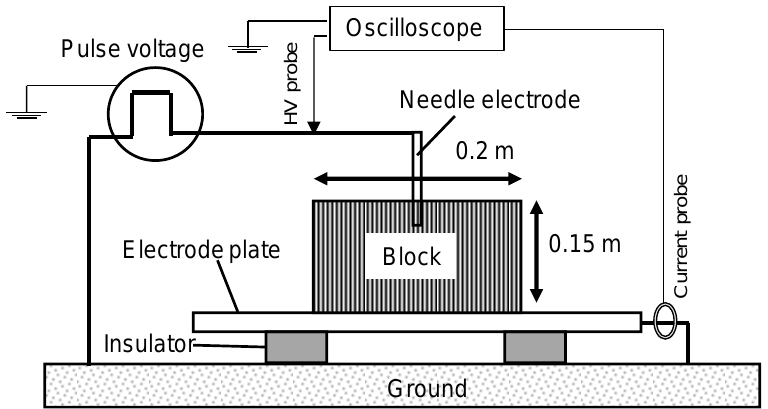
Figure 6. Experimental setup for pulsed voltage stimulation to the Lyophyllum deeastes Sing. sawdust block.